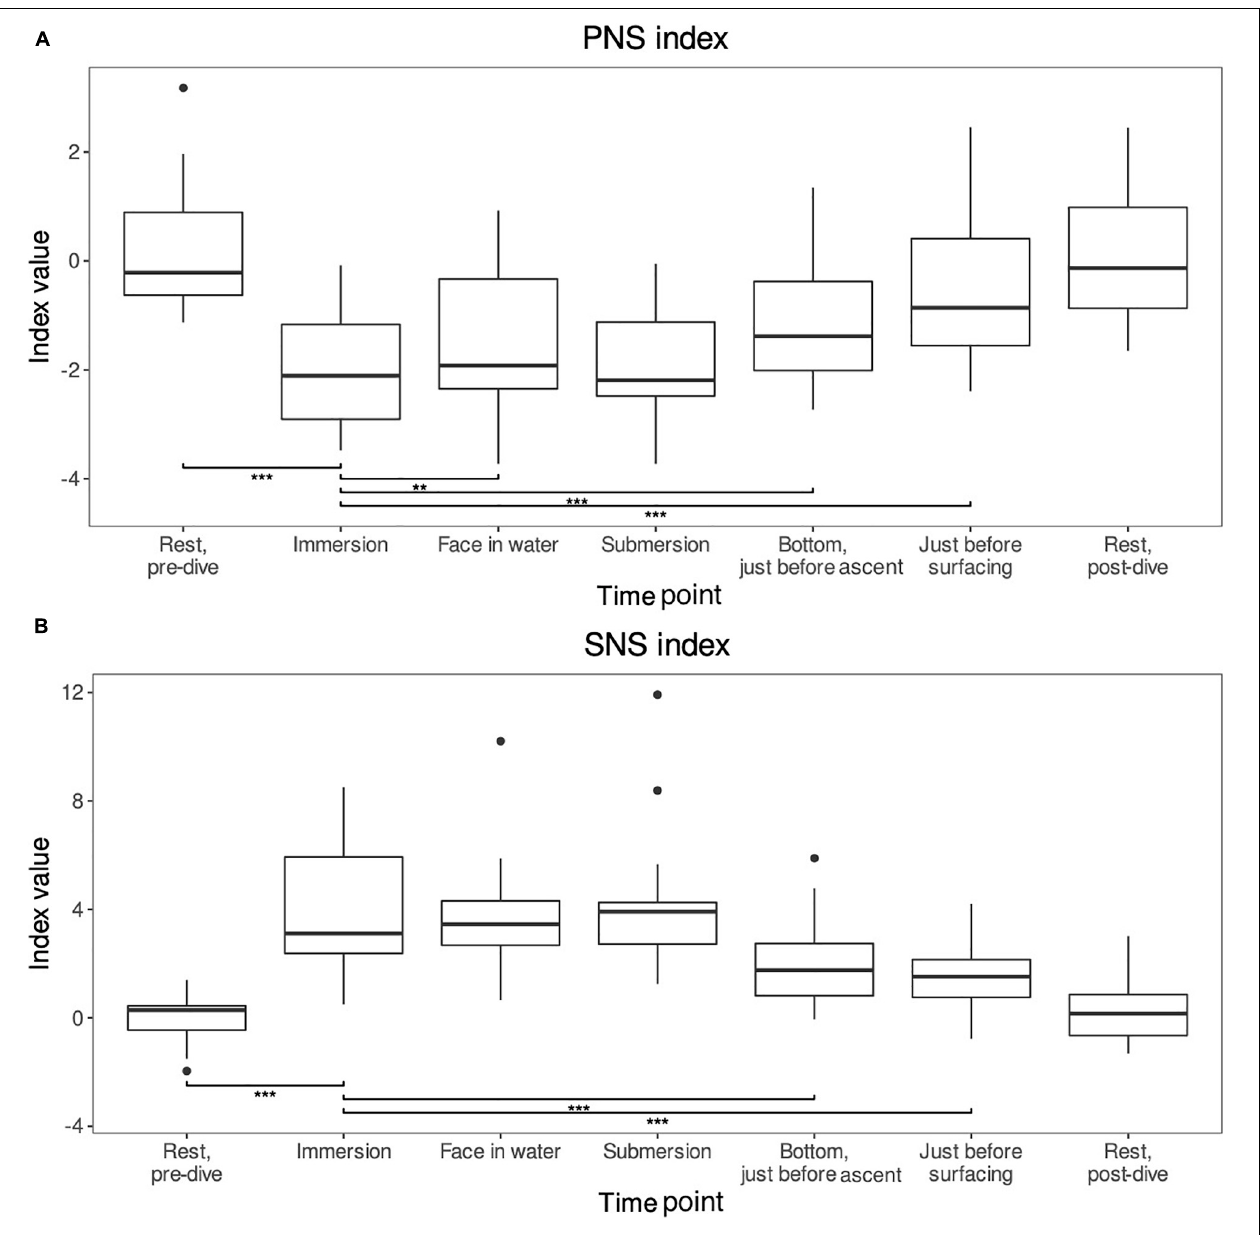
FIGURE 2 | (A,B) The PNS and SNS indexes reported by the Kubios HRV standard program. These indexes provide reliable estimates of the autonomic nervous system activities compared to normal resting values (Sahoo et al., 2019). For comparisons, the level of significance is reported ** p < 0.01 and *** p < 0.001. Means and range shown ( n =